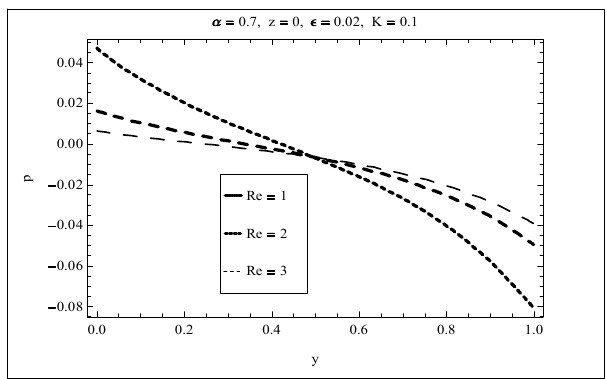
Figure 17. Effect of Re on pressure p along y .